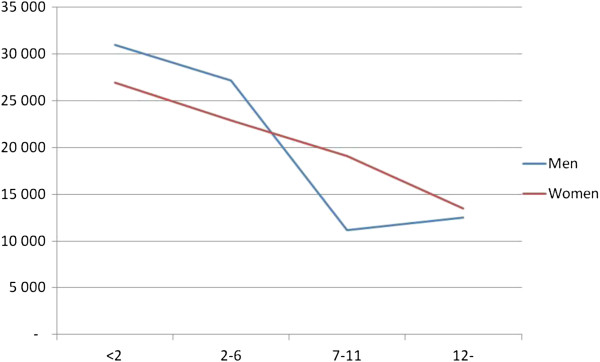
Cost-effectiveness ratios per QOL-AGDHA group and men and women. Each graph shows the cost-effectiveness ratio (vertical axis) as a function of the QOL-AGDHA score (horisontal axis).